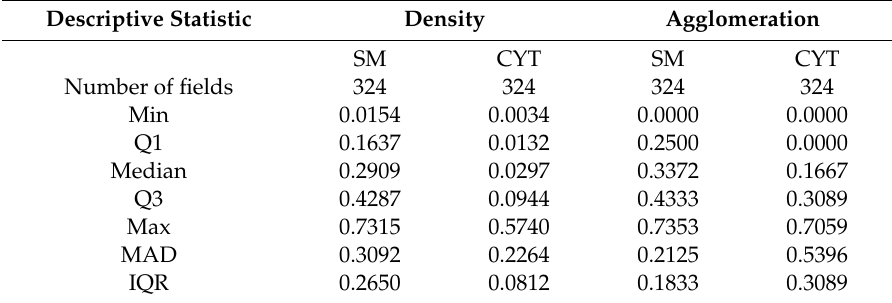
Table 3. Descriptive statistics for density and agglomeration empirical distributions.